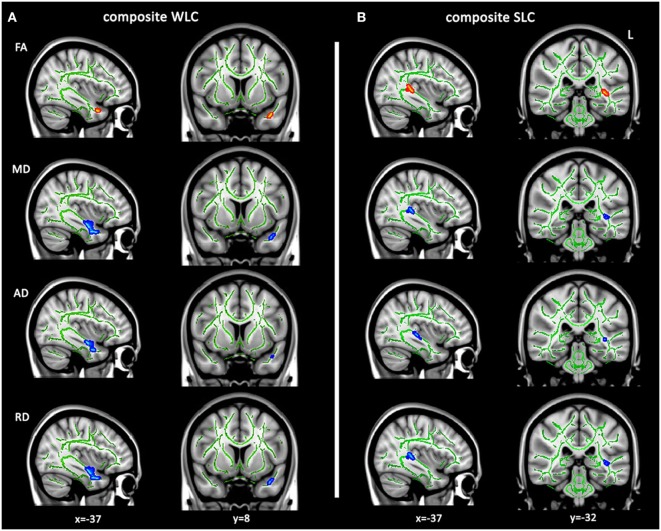
Tract-based spatial statistics analysis for white matter integrity related to language comprehension. Altered diffusion tensor imaging metrics related to composite WLC (A) and SLC (B) scores controlling for age and lesion volumes (TFCE corrected P < 0.05). Regions with significantly positive correlates of mean fractional anisotropy (FA) (red–yellow) or negative correlates of mean diffusivity (MD), axial diffusivity (AD), and axial diffusivity (RD) (blue–light blue) with individual comprehension scores are overlaid on the FMRIB58 FA skeleton (green), displayed on a template in Montreal Neurological Institute space. WLC, word-level comprehension; SLC, sentence-level comprehension.